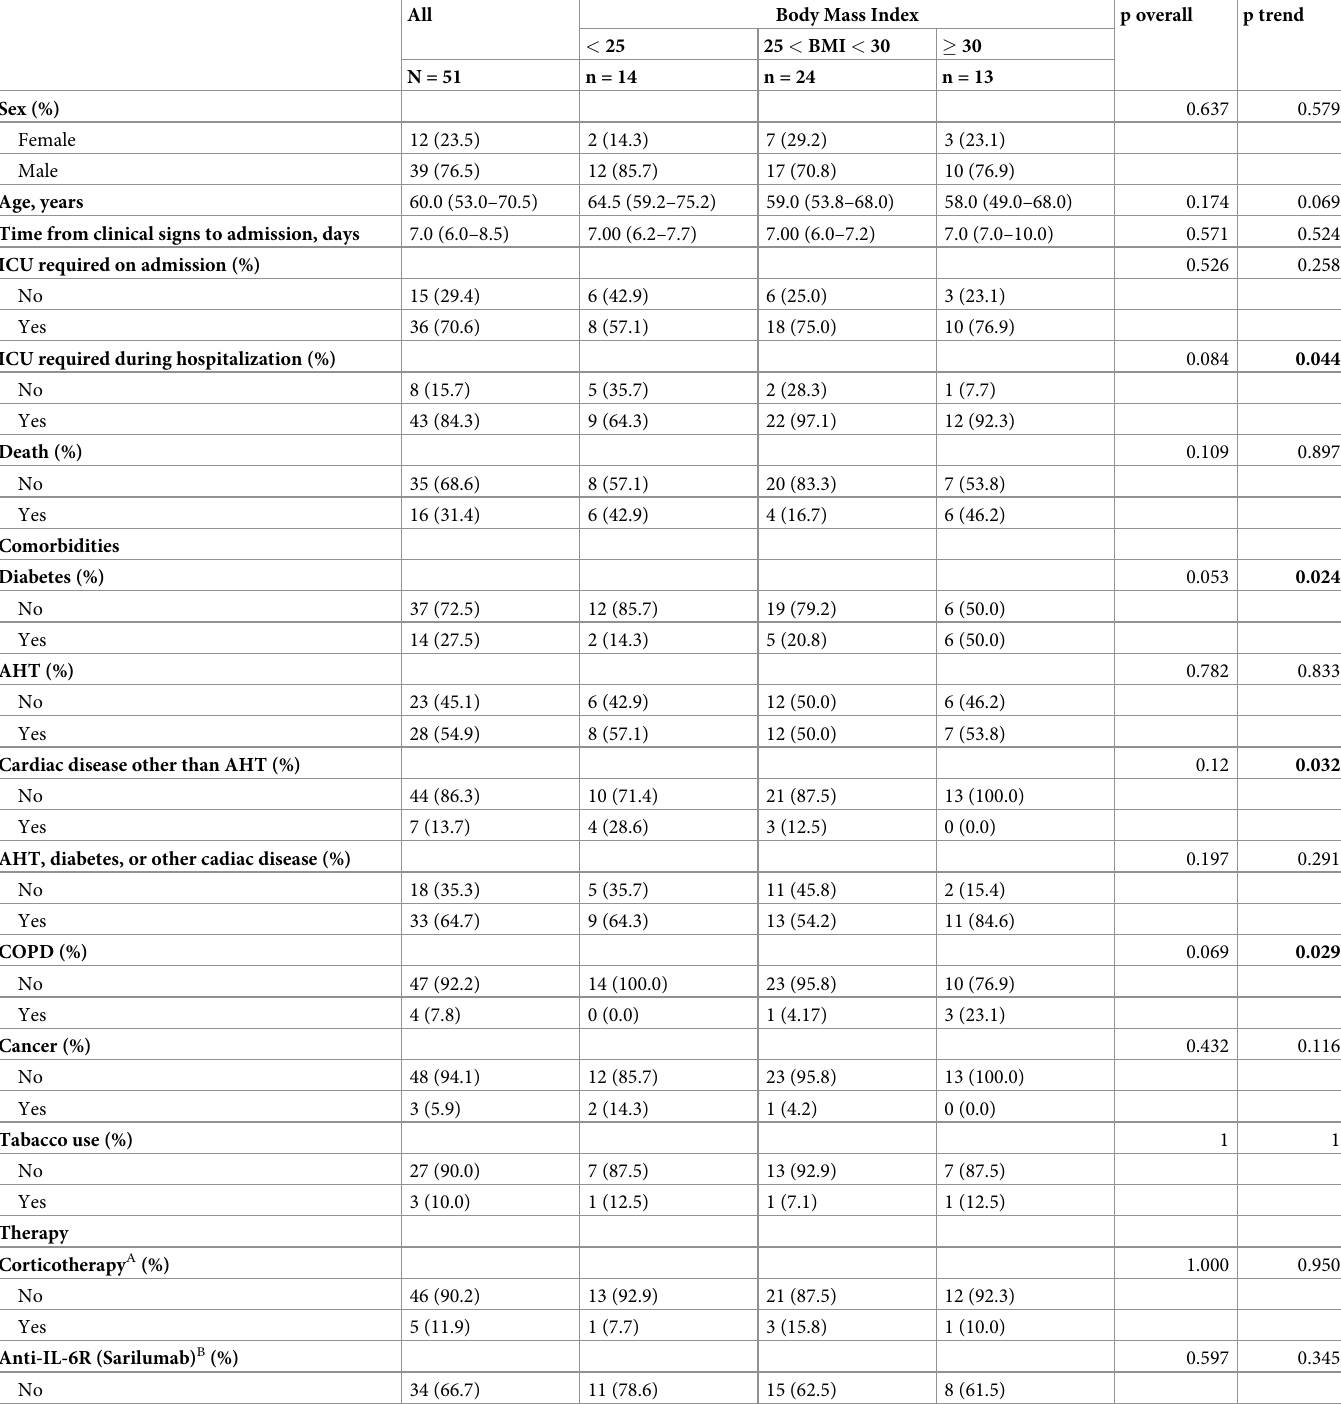
Table 1. Demographic and clinical